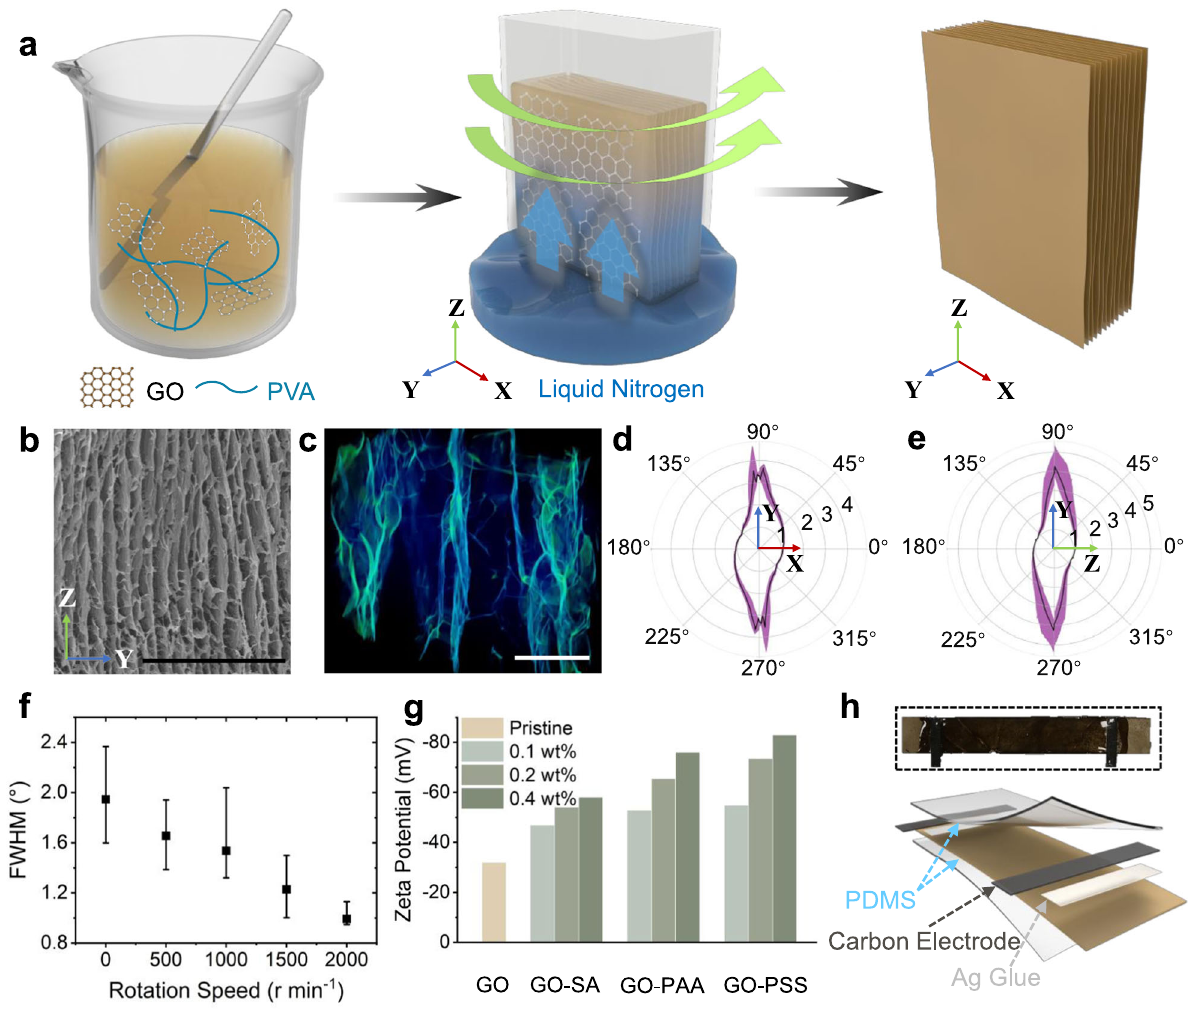
Fig. 2 | Preparation and characterization of 2D-WEG. a Schematic illustration of the preparation process of GO assembled framework by the rotational freeze- casting method. b Thecross-sectionscanningelectronmicroscope (SEM)imageof GO assembled framework taken along the X -axis directions. Scale bar: 500 μ m. c The 3D structure reconstructed from X-ray tomography images of the GO assembled framework, which shows the GO sheets (indicated by the bright blue area)arrangedinspace(blackarea)paralleltothe X – Z plane.Scalebar:50 μ m.The valueoftortuosityindifferentdirectionsin dX – Y planeand eY – Z plane,wherethe